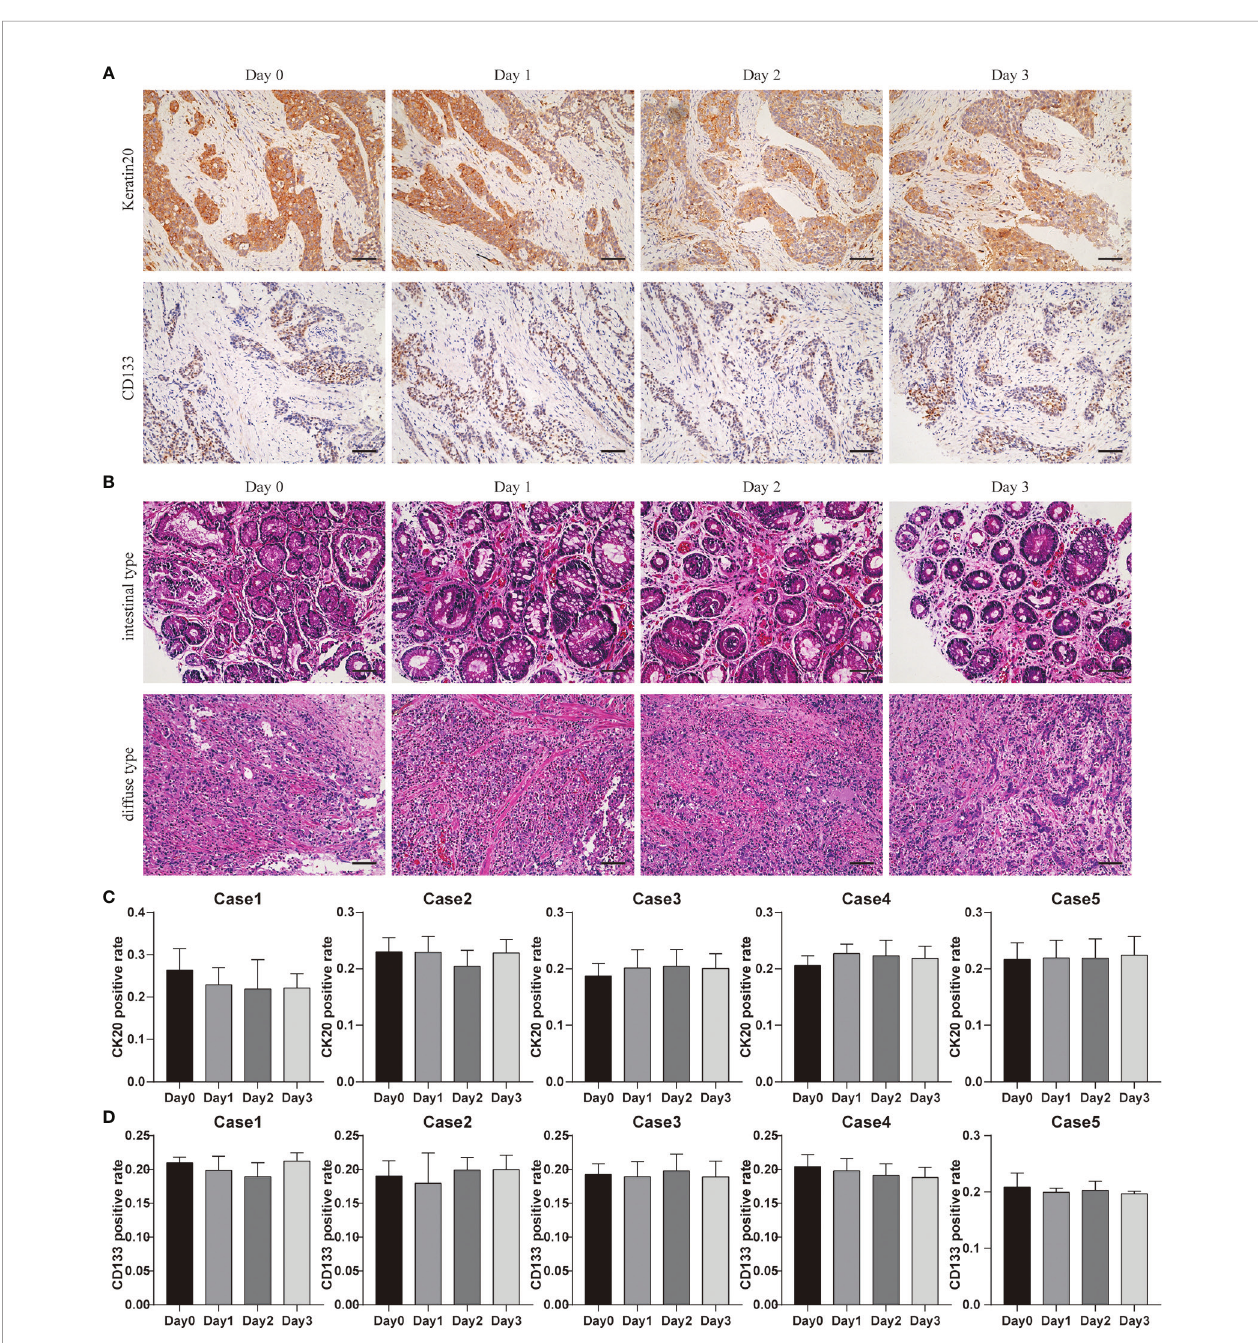
FIGURE 5 | Cancer cellular and structural integrities within GC tissue. (A) Keratin20 staining of Case1 before and after 3 days of culture, scale bar, 100 m m. CD133 staining of Case4 before and after 3 days of culture, scale bar, 100 m m. (B) Case13 was intestinal type carcinoma and Case17 was diffuse gastric carcinoma, and the H&E staining at different time points were laid out. Compared with results before culture (day0), the cancer cell distributions and structure integrities were not changed a lot after 3 days of culture. All images are the same magni fi cation, scale bar, 100 m m. (C) Keratin20 quantitative analysis of Case1-Case5 before and after 3 days of culture. (D) CD133 quantitative analysis of Case1-Case5 before and after 3 days of